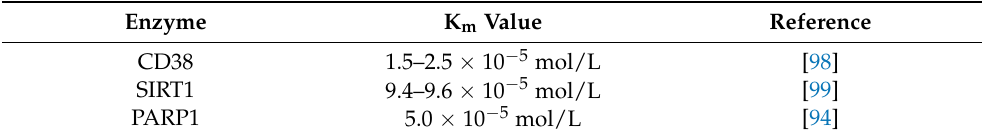
Table 1. K m values of the main NAD + -consuming